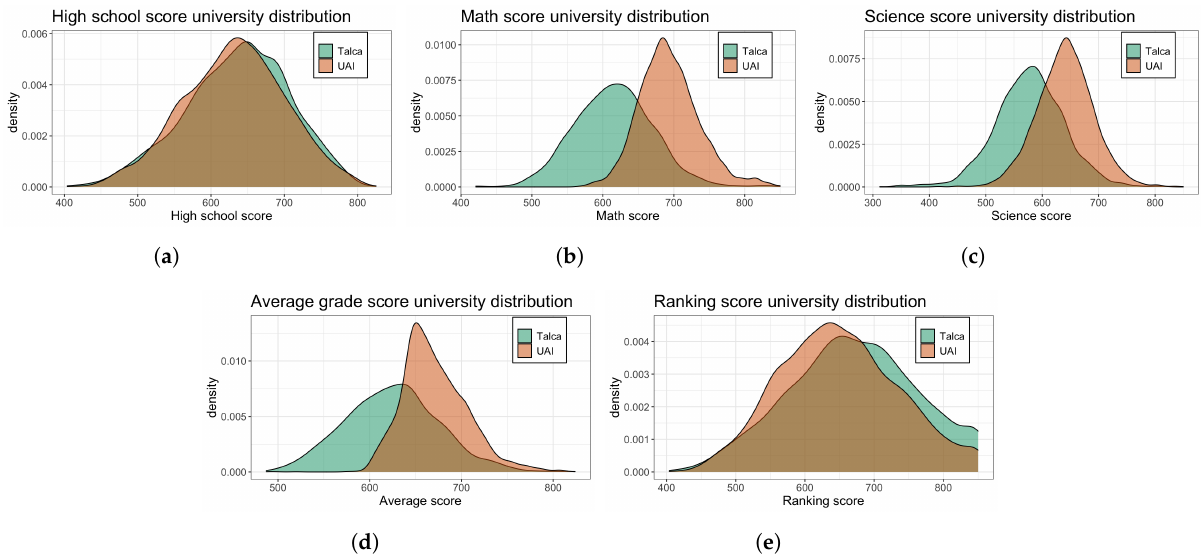
Figure 3. Score conditional distributions based on the DROPOUT variable, with respect to each variable within the combined dataset. ( a ) Variable nem. ( b ) Variable mat. ( c ) Variable optional. ( d ) Variable pps. ( e ) Variable ranking.